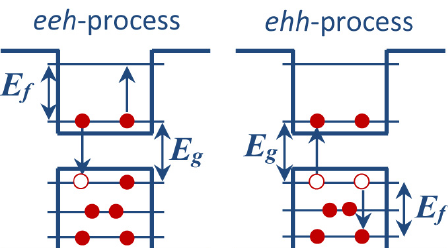
Figure 2. Auger recombination in nanocrystals via eeh and ehh processes. Arrows indicate Auger transitions between the initial and final